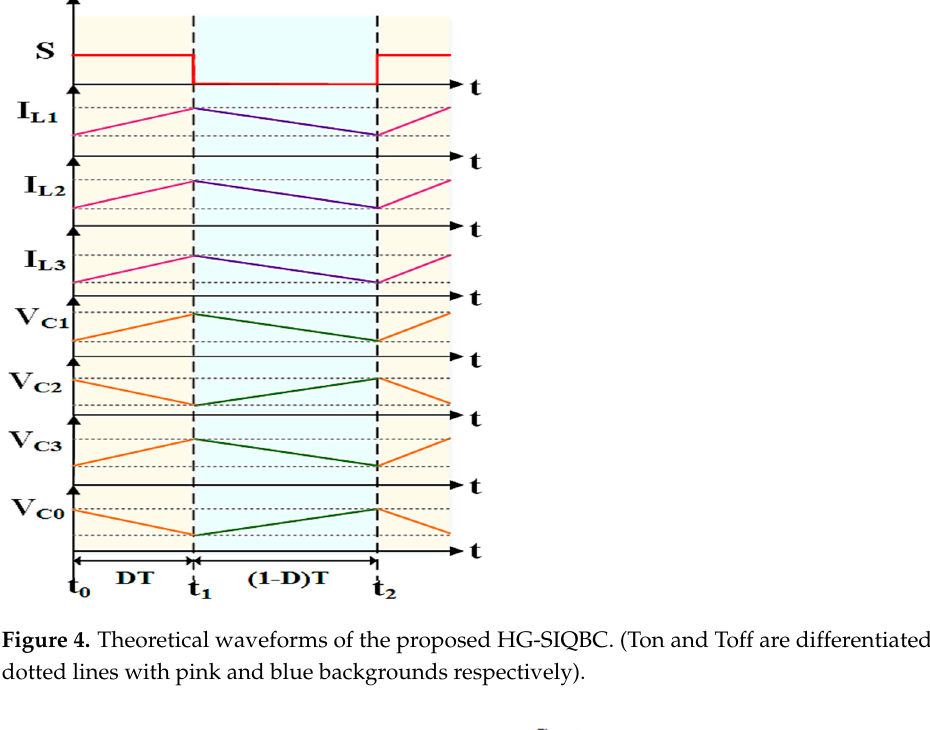
Figure 4. Theoretical waveforms of the proposed HG-SIQBC. (Ton and Toff are differentiated with dotted lines with pink and blue backgrounds respectively).